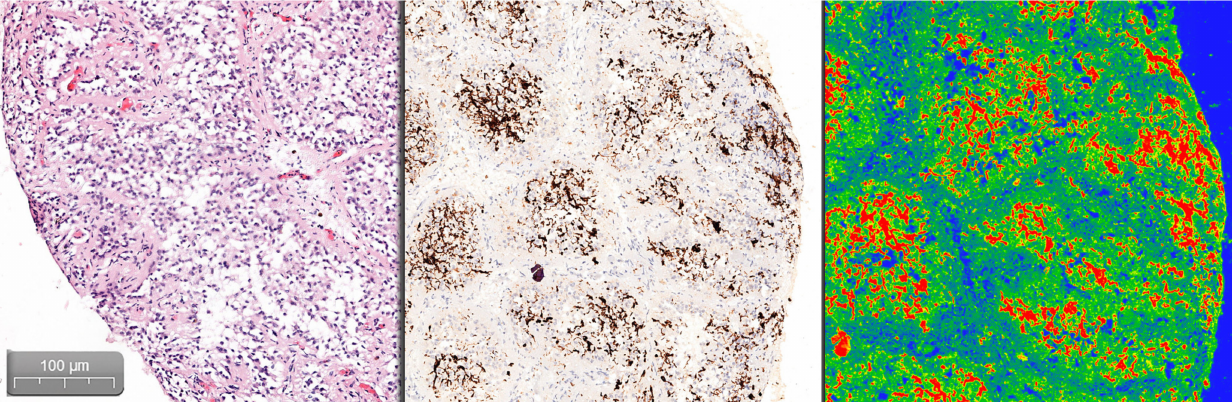
Figure 2. Comparative view of the H&E, GFAP, and gradient-map mode of the GFAP digital slide as seen in CaseViewer by 3DHISTECH (Budapest, Hungary).